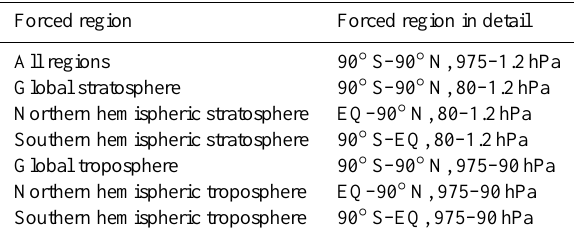
Table 1. List of regions where external forcings are